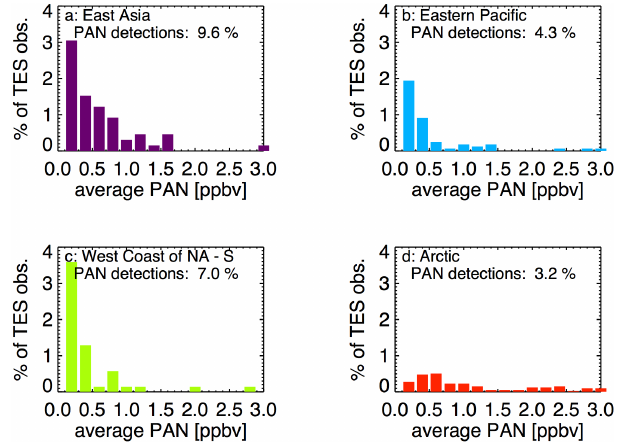
Figure 11. Incidences of elevated PAN as observed by TES during April 2008 in the latitude–longitude boxes shown in Fig. 10. VMR values represent the average for points in the profile where the sum of the row of the averaging kernel is greater than 0.5.